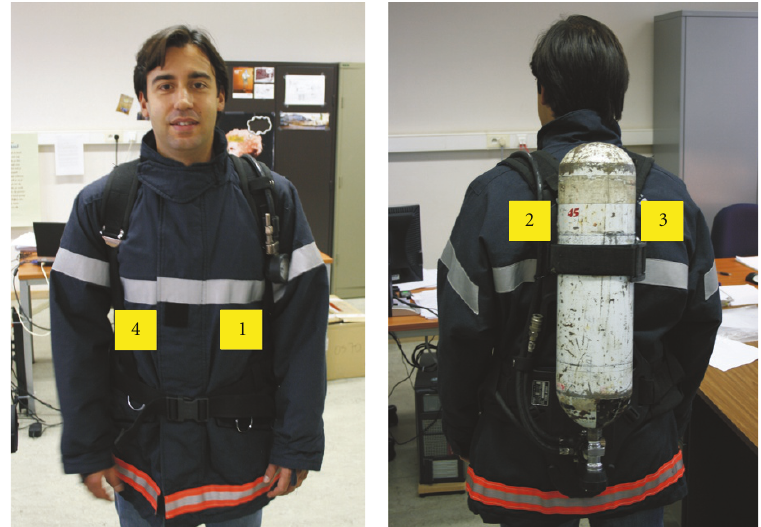
Figure 1: Position of the 2 . 45 GHz circularly polarized textile patch antennas integrated into the fireman’s garment.